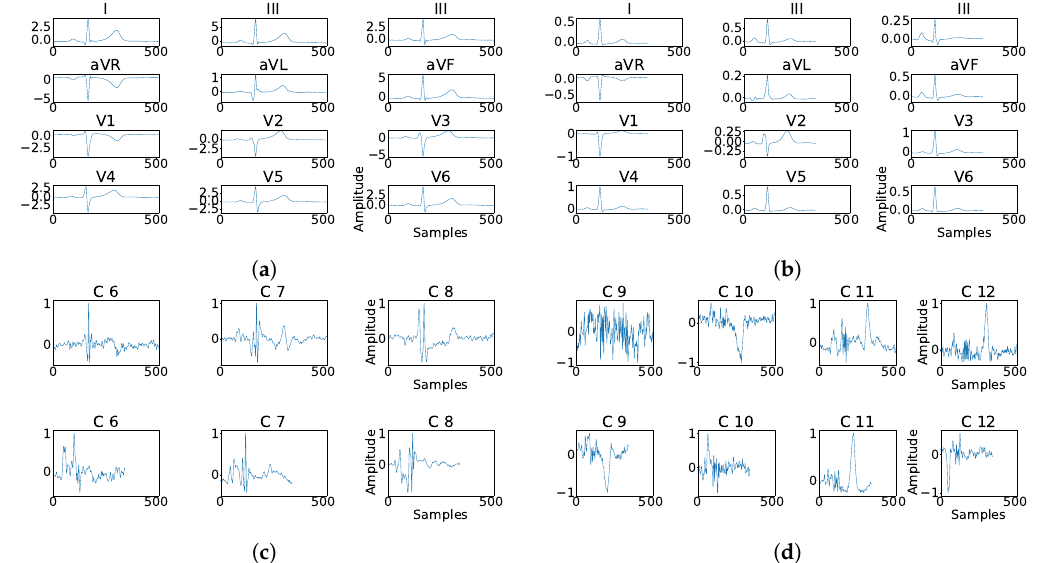
Figure 17. Example of fragmentation wave enhancement over real fragmented case. ( a ) Beat templates for each lead of real fragmented case. ( b ) Beat templates for each lead of control case. ( c ) Results of the best PCA method for the real fragmented case, in top subpanels and control case in bottom panels. ( d ) Results of the best ICA method for the real fragmented case, in top subpanels and for the control case in bottom panels.